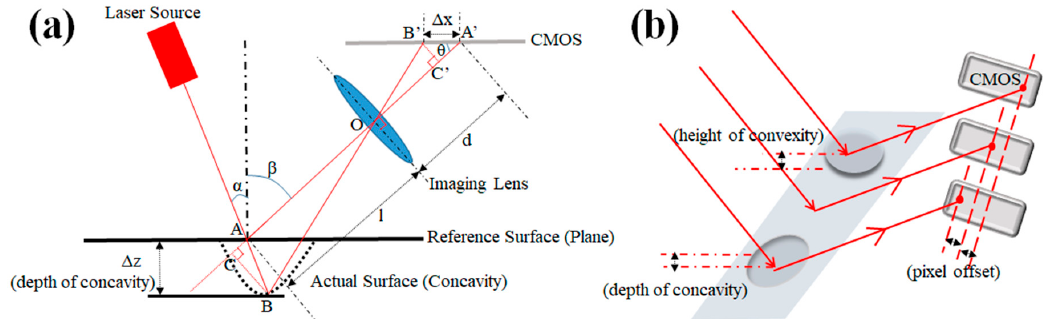
Figure 2. ( a ) Schematic diagram of the universal oblique laser triangulation. The reference surface refers to the plane of the sample to be inspected were it to be an ideal flat surface as opposed to the actual surface including surface imperfections. We refer to concavities or convexities for cases when the actual surface is below or above the reference surface (the dotted line in the figure indicates a concavity). O is the origin of the lens plane, A is a point on the reference surface, B is a point on the actual surface. Both A and B are illuminated by the light-sheet, and A (cid:48) and B (cid:48) are their respective images. α is the angle between the incident light and the surface normal, β is the angle between the elastically scattered light and the surface normal. l is the distance from object point A to the imaging lens and d is the image distance, which satisfies the lens equation. ∆ z is the depth / height of a concavity / convexity and ∆ x is the length of A (cid:48) B (cid:48) in the CMOS plane. θ is the angle between AA (cid:48) and the plane of the CMOS camera. f is the focal length of the imaging lens. In our system, both α and β are set to 45 ◦ , and θ is set to 90 ◦ , as discussed below. ( b ) Schematic illustration of the relationship between the depth / height of a concavity / convexity and the pixel o ff set in the CMOS camera. A concavity / convexity in the surface corresponds to a pixel shift to the left /